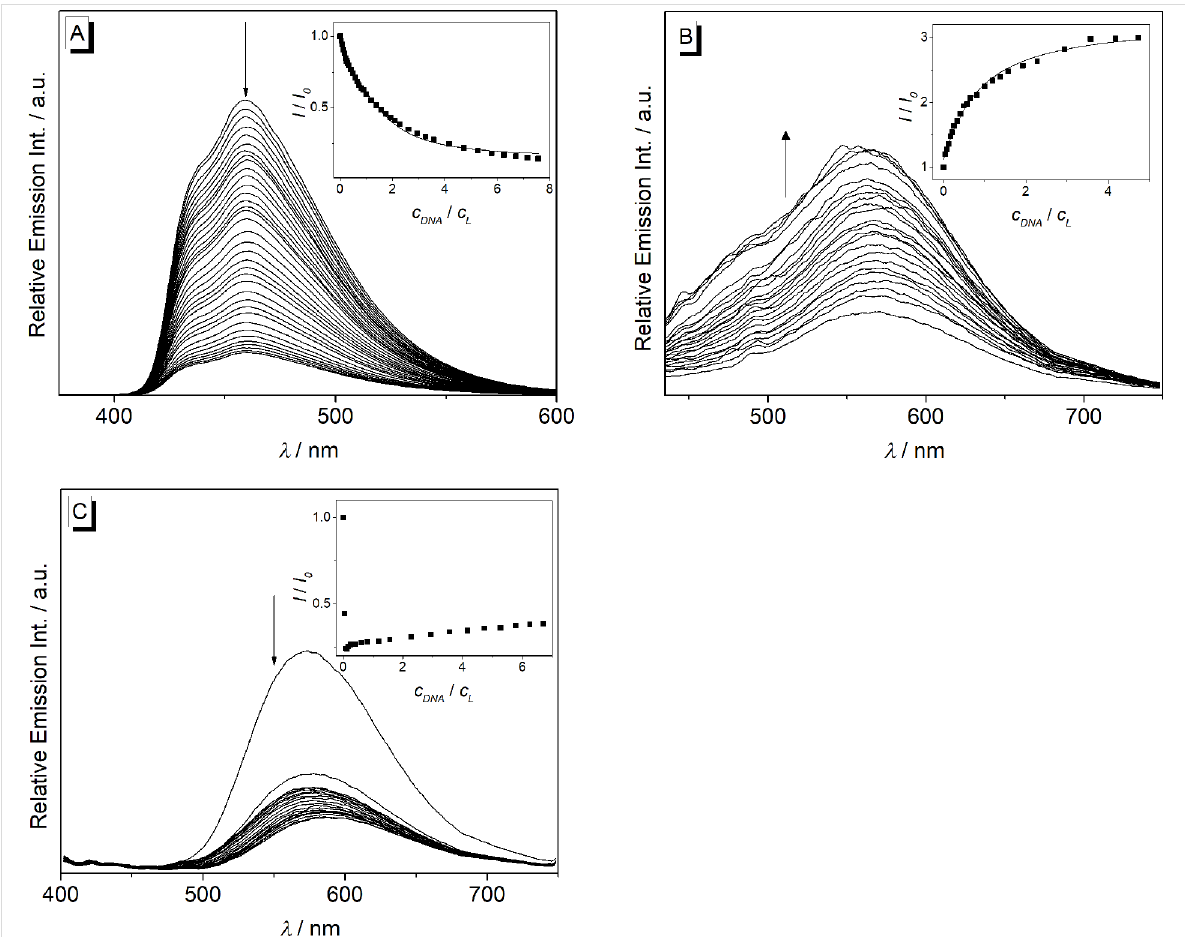
Figure 8: Fluorimetric titration of 2a (A), 2b (B) and 2d (C) with ct DNA in potassium phosphate buffer (95 mM K + ; 5% DMSO; pH 7.0); c Ligand = 20.0 μ M. Arrows indicate the development of the bands with increasing DNA concentration. Inset: Plot of the relative emission intensity, I / I 0 versus c DNA / c L . Lines denote the best fit of experimental data to the theoretical model; λ ex = 335 nm (A), 420 nm (B) and 380 nm (C).